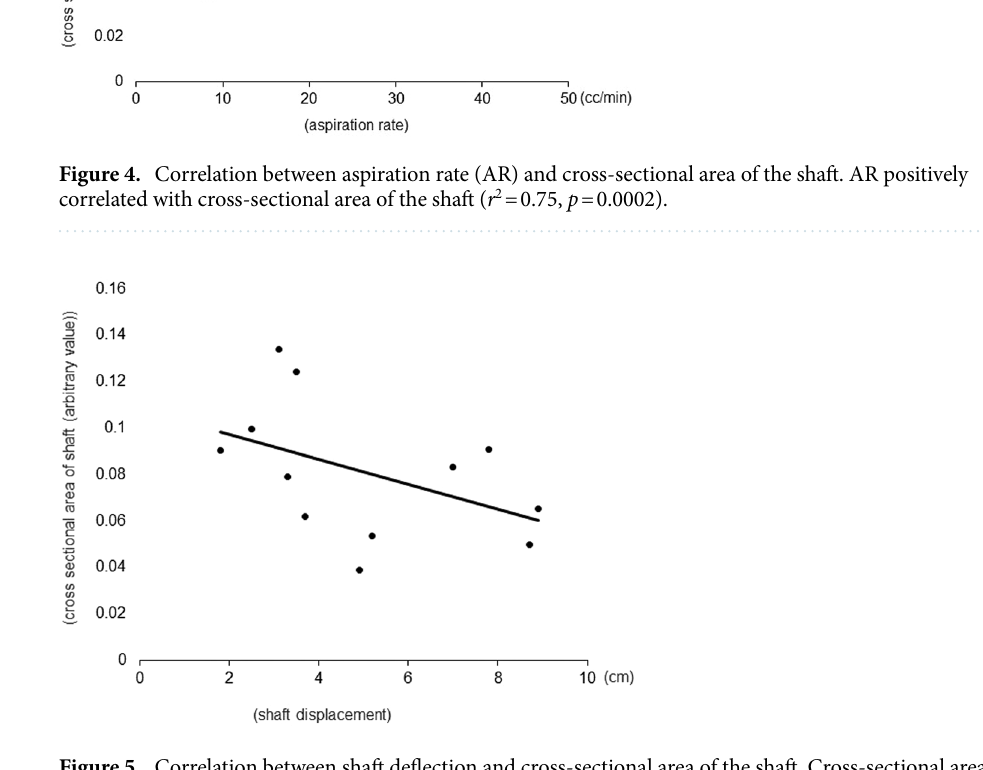
Figure 5. Correlation between shaft deflection and cross-sectional area of the shaft. Cross-sectional area of the shaft negatively correlated with the degree of shaft displacement ( r 2 = 0.21, p =